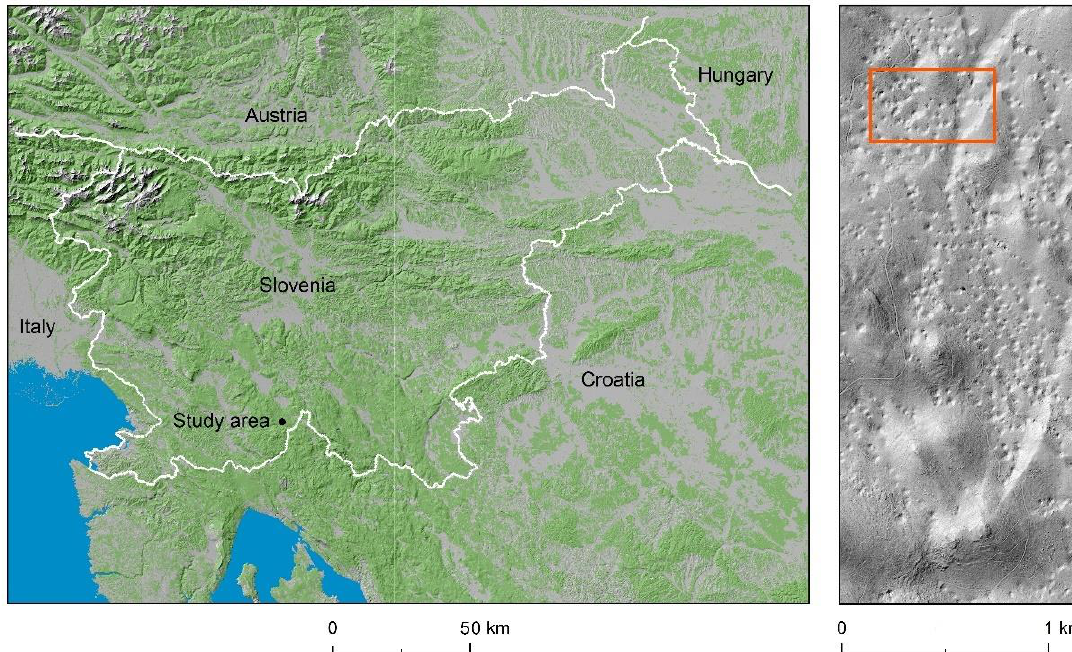
Figure 1. Location of study area in the Dinaric Mountains presented on a section of the shaded relief of the Digital Elevation Model over Europe [35] and right: the research area as seen from a section of the shaded relief of the Digital Terrain Model (DTM) of Slovenia [36].